Question: Based on the figure, does the quantity rise or fall?
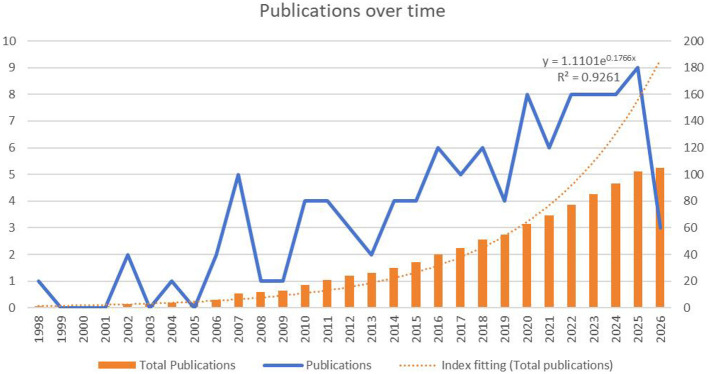
Answer: increasing